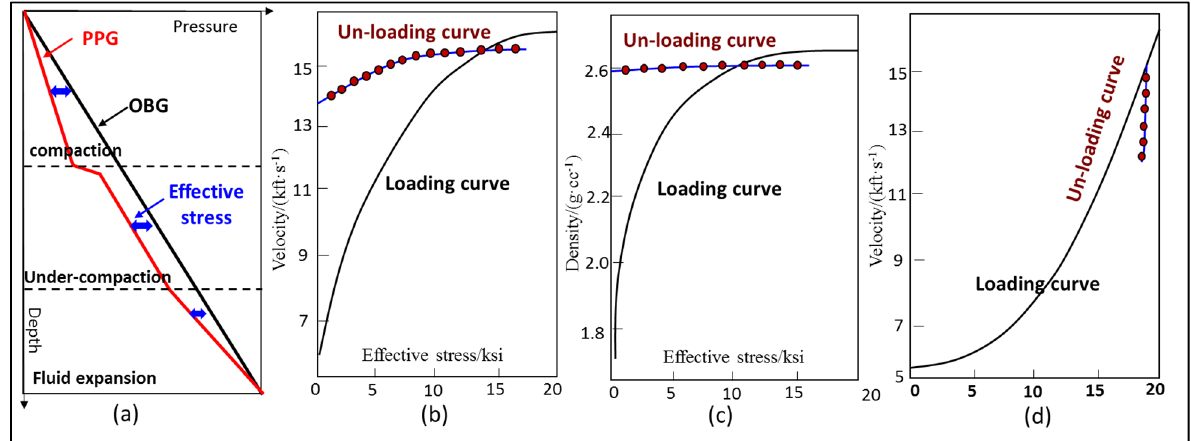
Figure 3. Effective stress response to different overpressure mechanisms and Bowers diagram. (Modified from [5].)